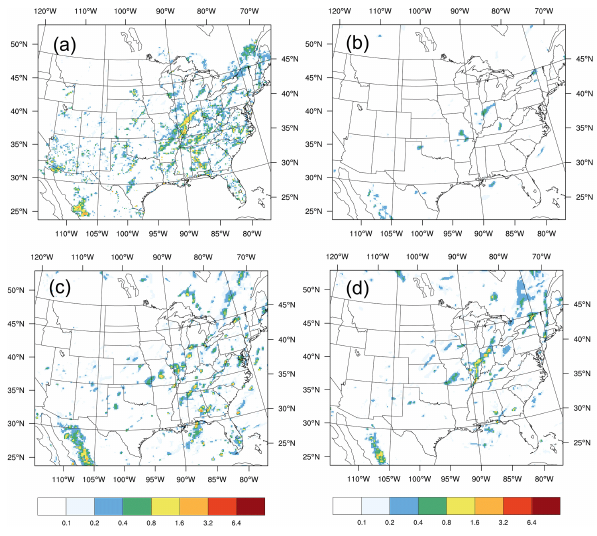
Figure 10. Averaged accumulated precipitation (unit: mm) in the first forecast hour. (a) Stage IV observation, experiment (b) GFS, (c) FullCycle, and (d)